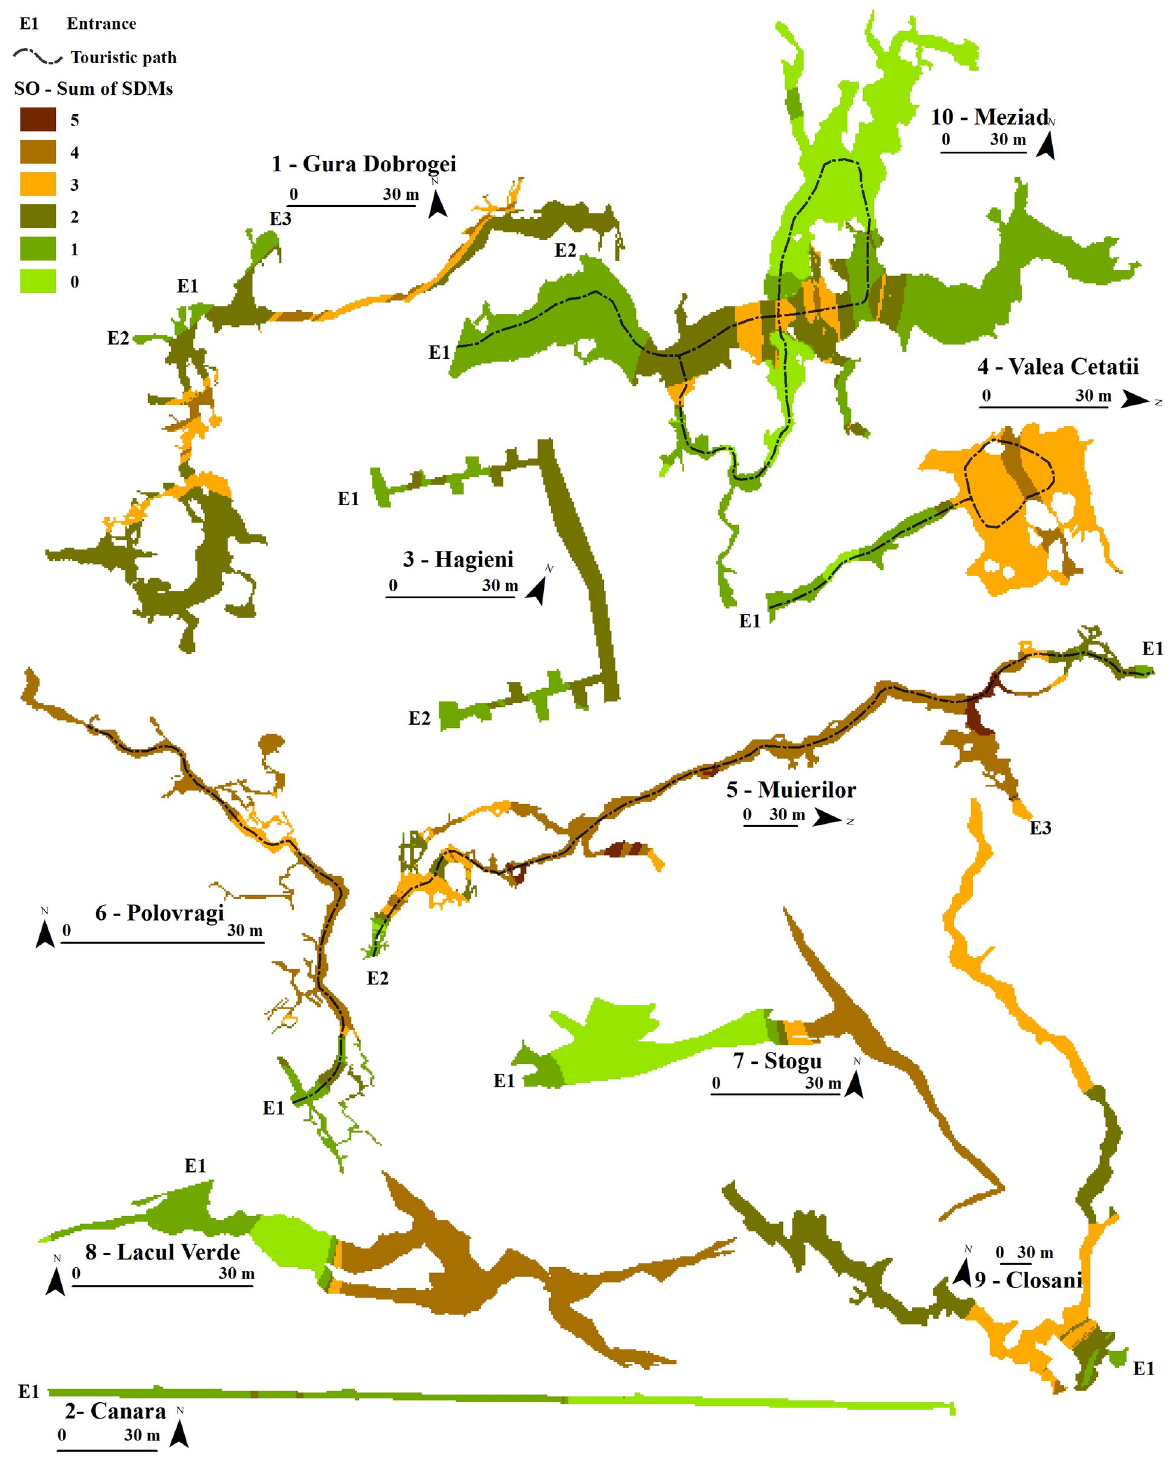
Fig 3. Ensemble SDMs for the September–October—(SO) start of the hibernation period for all the studied SEs. Sum of SDMs shows the number of suitable habitats which overlap within a SE.